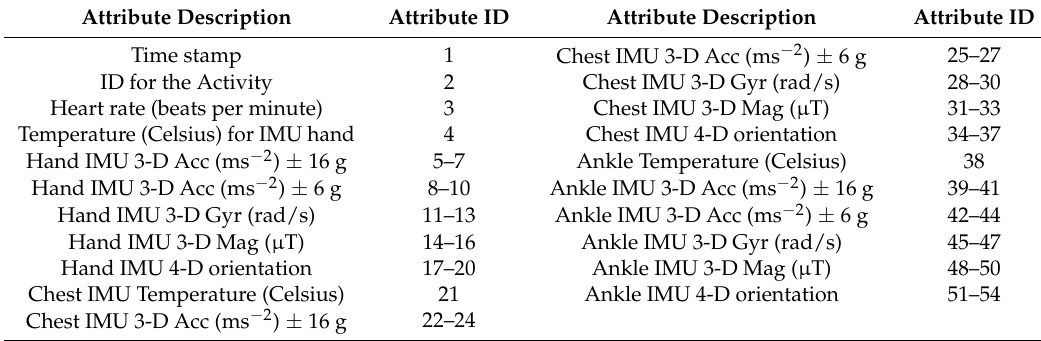
Table 1. PAMAP2 Dataset Attribute Description.